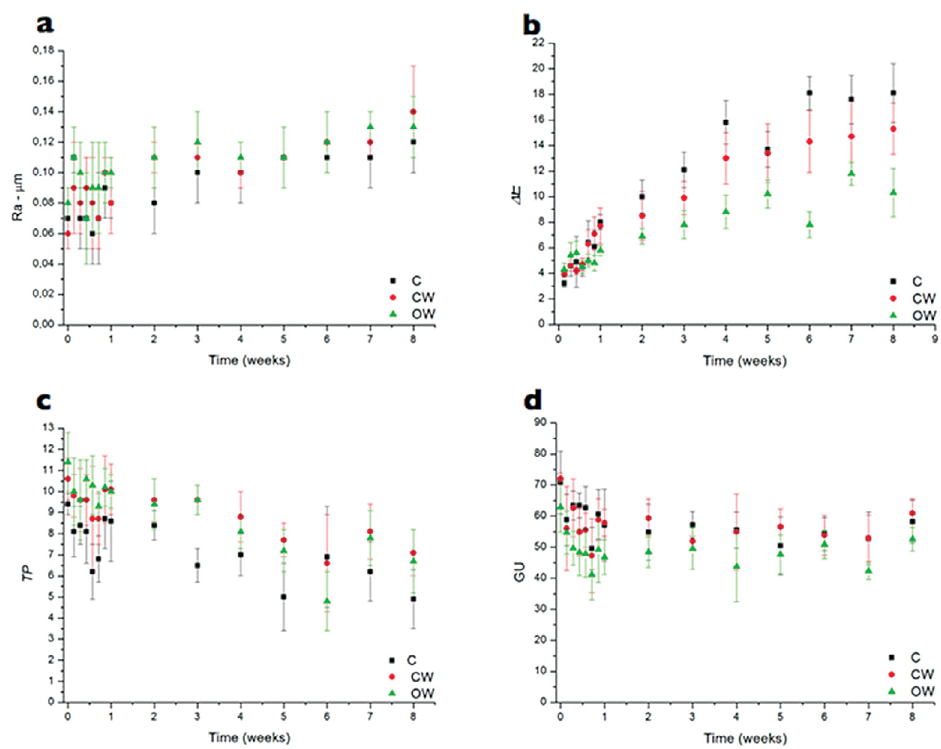
Figure 3- Curves of evolution of properties vs. time for the three toothpastes: roughness (a), color (b), translucency (c) and gloss (d)